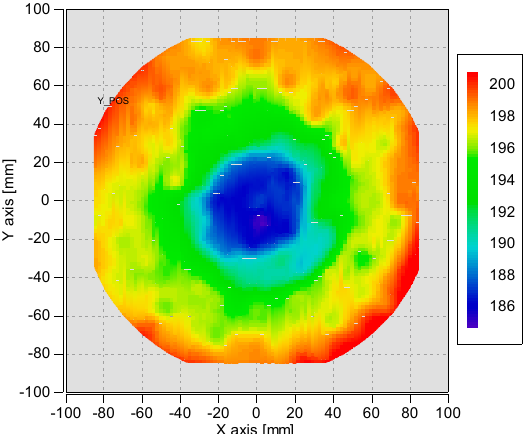
Figure 2. NO x concentration [ppm] measured at the SCR outlet face without an active water–urea solution (UWS) dose.